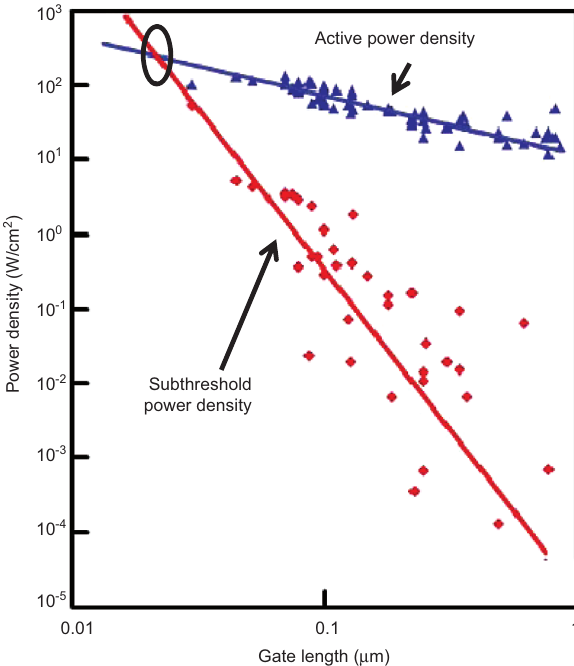
Figure 1 Power density of the active region (blue line) and subthreshold region (red line) from commercial Si MOSFETs. The subthreshold power density takes more and more proportion of the total power consumption with the scaling of gate length. The subthreshold leakage power density will be higher than the active power density if the gate length is below the cross point of these two lines as labeled in the figure. Reprinted from Ref. [1], with per- mission, from IBM Technical Journals.